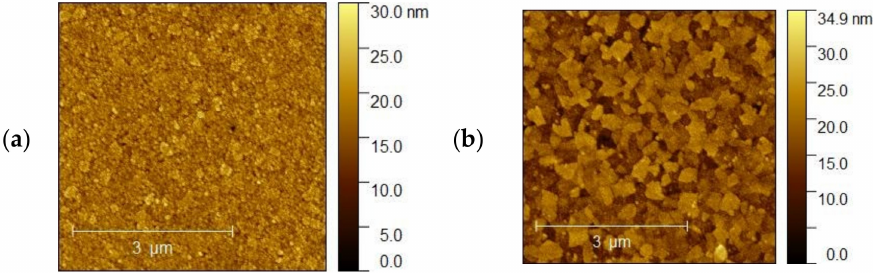
Figure 11. ( a , b ). AFM images of the ( a ) ITO3 for 5 nm and ( b ) ITO4 for 5 nm.